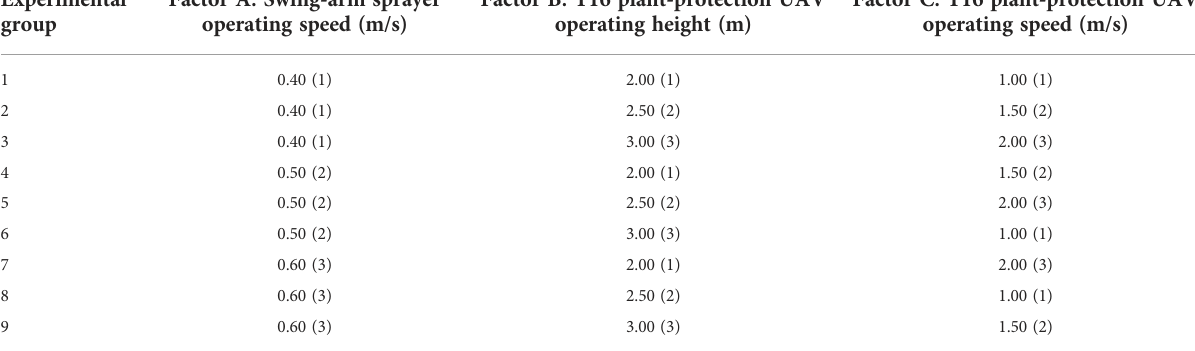
TABLE 3 Three-factor with three-level orthogonal experiment table for the SPS. Experimental